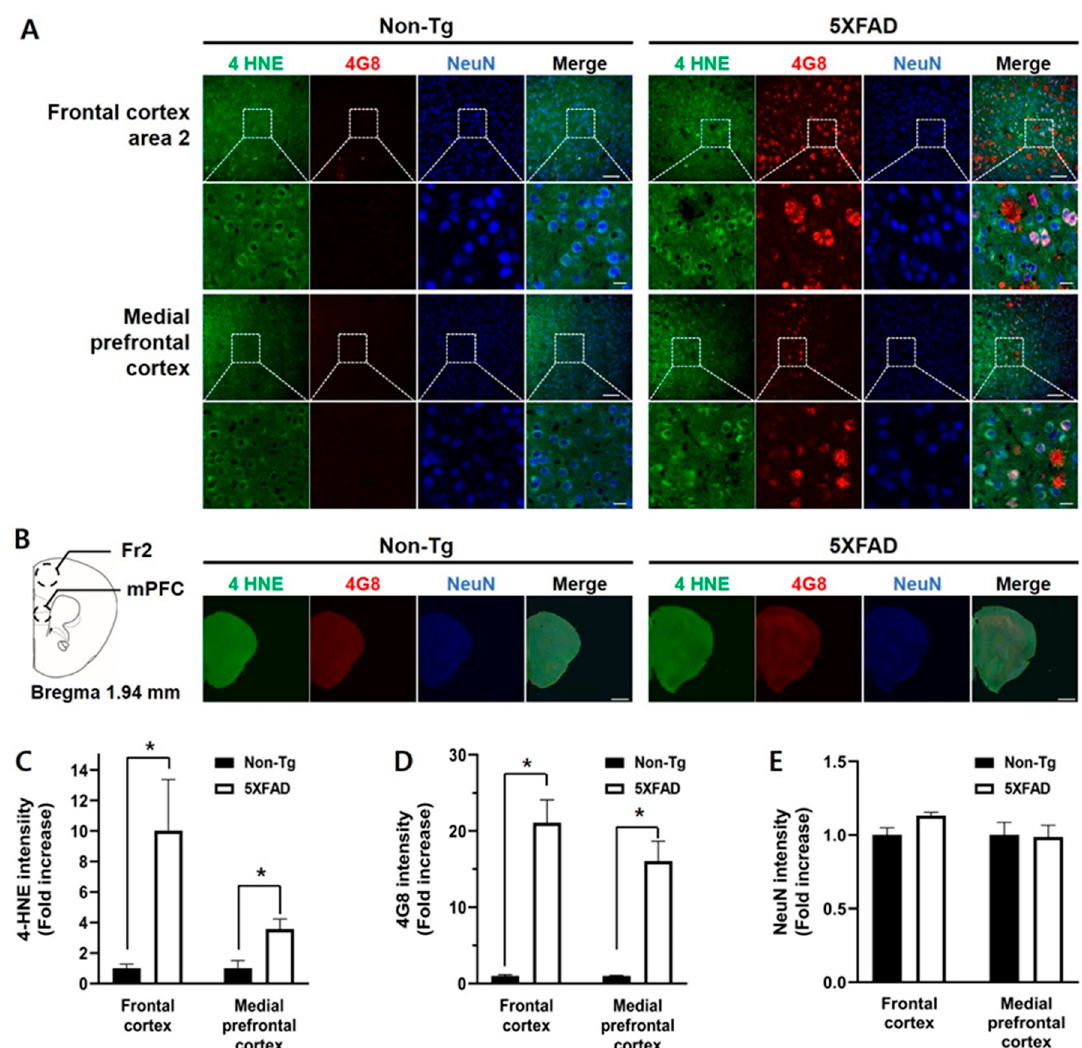
Figure 3. Triple immunofluorescence staining of the frontal cortex of the 4-month-old non-Tg control and 5XFAD mice. ( A ) Confocal microscopic images of triple immunofluorescence with 4-HNE, 4G8, and NeuN antibodies in the frontal cortex area 2 (Fr2) and medial prefrontal cortex (mPFC). ( B ) Schematic diagram of the analyzed brain regions and half-brain immunofluorescence images. The dashed circles in the diagram indicate the regions of interest. ( C ) 4-HNE levels in the Fr2 and mPFC in 5XFAD mice were significantly higher than those in control mice. ( D ) A β levels in the Fr2 and mPFC in 5XFAD mice were significantly higher than those in control mice. ( E ) There was no difference in the intensities of the NeuN-positive signal. Top row: scale bar indicates 100 μ m; bottom row: scale bar indicates 20 μ m. Non-Tg, n = 4; 5XFAD, n = 6. * p < 0.05.